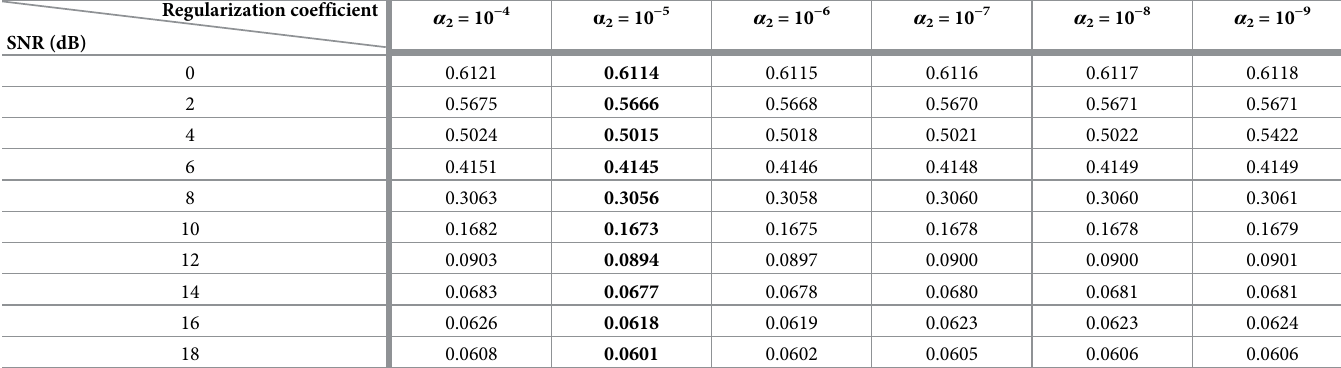
Table 6. The effect of regularization coefficient α 2 on NMSE performance. Regularization SNR (dB)